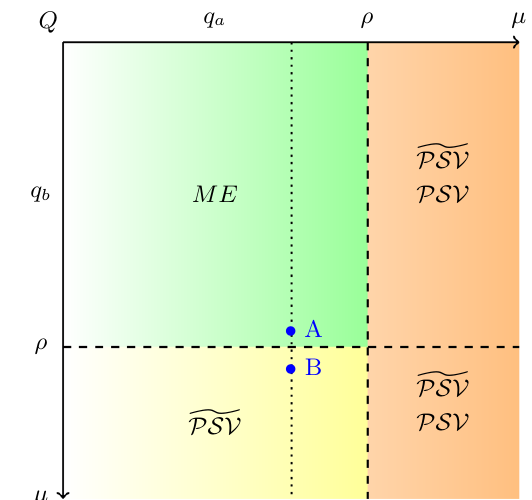
Fig. 1 Simplifiedexampleforanemissionphasespacewithtwopossi- bilities D a , D b to fill. The ME region is defined, when the scales of both clusterings are above a given scale ρ . The modified veto shower (cid:2) PSV needs to fill the remaining region as it would have been filled without division of the phase space. Emission by D a can be created above ρ , if the scale for D b is below ρ . A simplified vetoed shower PSV would miss the yellow region for emissions above ρ . Further details and an explanation of the emissions A and B are given in the text